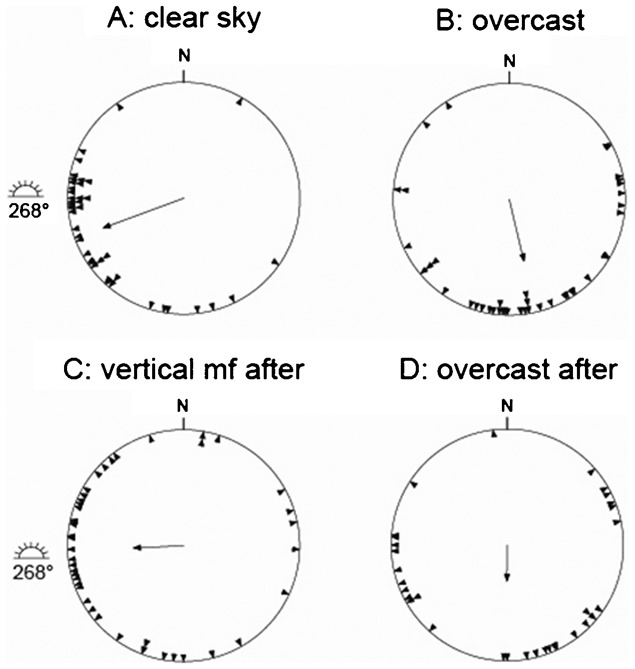
Results from our outdoor orientation cage experiments with juvenile European robins, Erithacus rubecula at Stensoffa Ecological Field Station in South Sweden during autumn migration.(A) Clear sky, (B) overcast sky, (C) exposure under clear skies without magnetic cues at vertical magnetic field vector, and (D) simulated overcast as a control after cue-conflict exposure. For further information, see legend of Fig. 1.